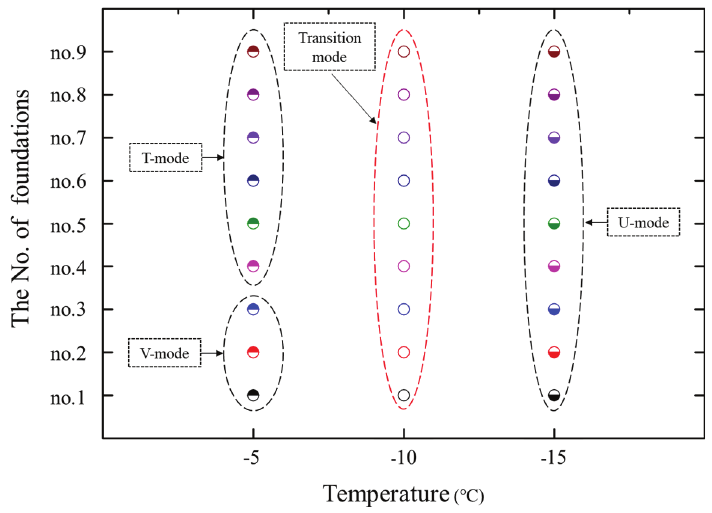
Figure 18. Distribution of T-mode, V-mode, and U-mode of nine foundations at three temperatures.